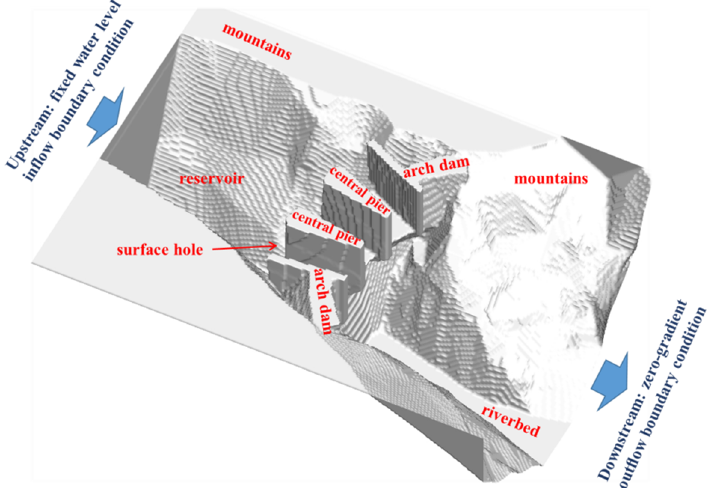
Figure 9. The geometry of flood discharge of an arch dam.